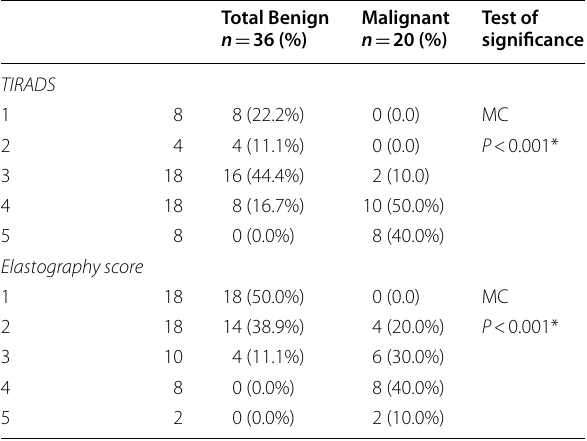
Table 1 comparison of TIRADS and elastography